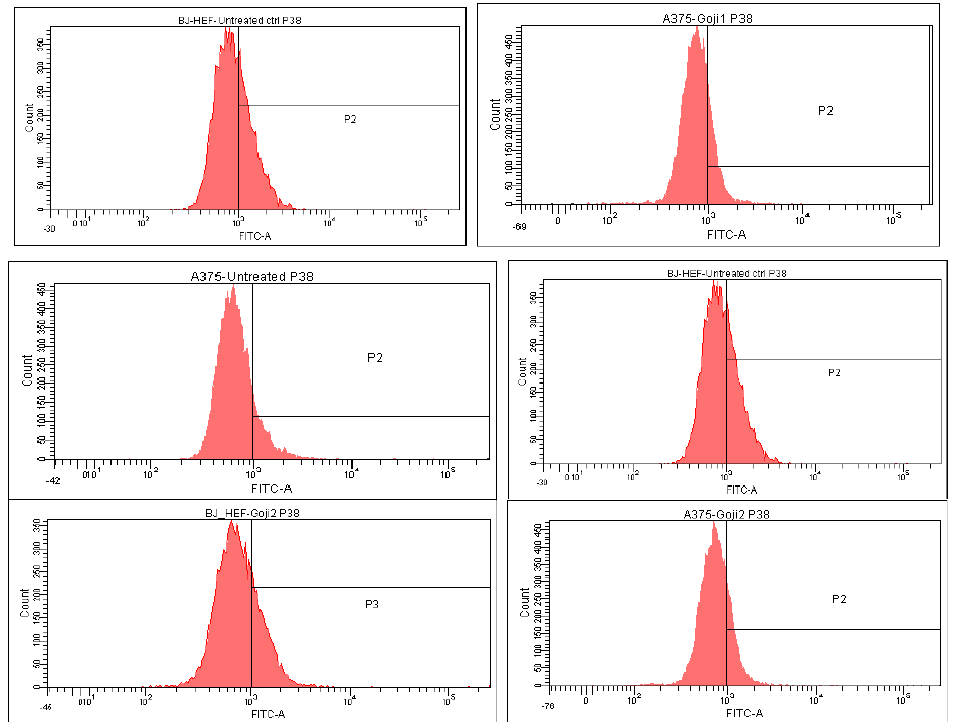
Figure 7. The intracellular p38 expression in normal BJ fibroblasts versus A375 malignant melanoma following the 24-h exposure to zeaxanthin-rich extracts 1 and 2 . In the left column are represented from top down: untreated cells, cells treated with 1, and cells treated with 2, respectively; in the right column, A375 cells, in the same order.